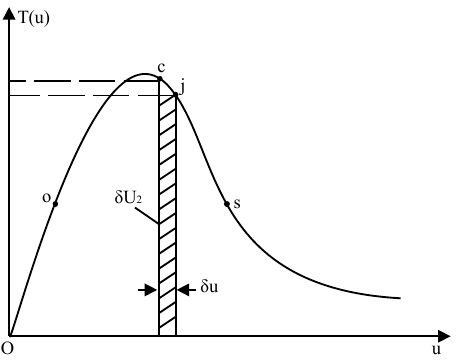
Figure 3. Relation curve between shear force and tangential displacement of locked section.